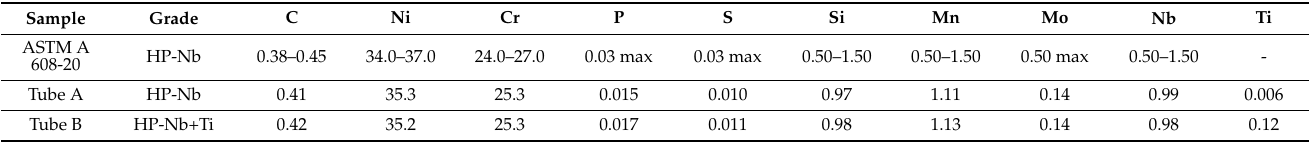
Table 1. The permitted range of various elements in the chemical composition of HP-Nb alloy along with the chemical composition of each tube, according to ASTM A 608-20